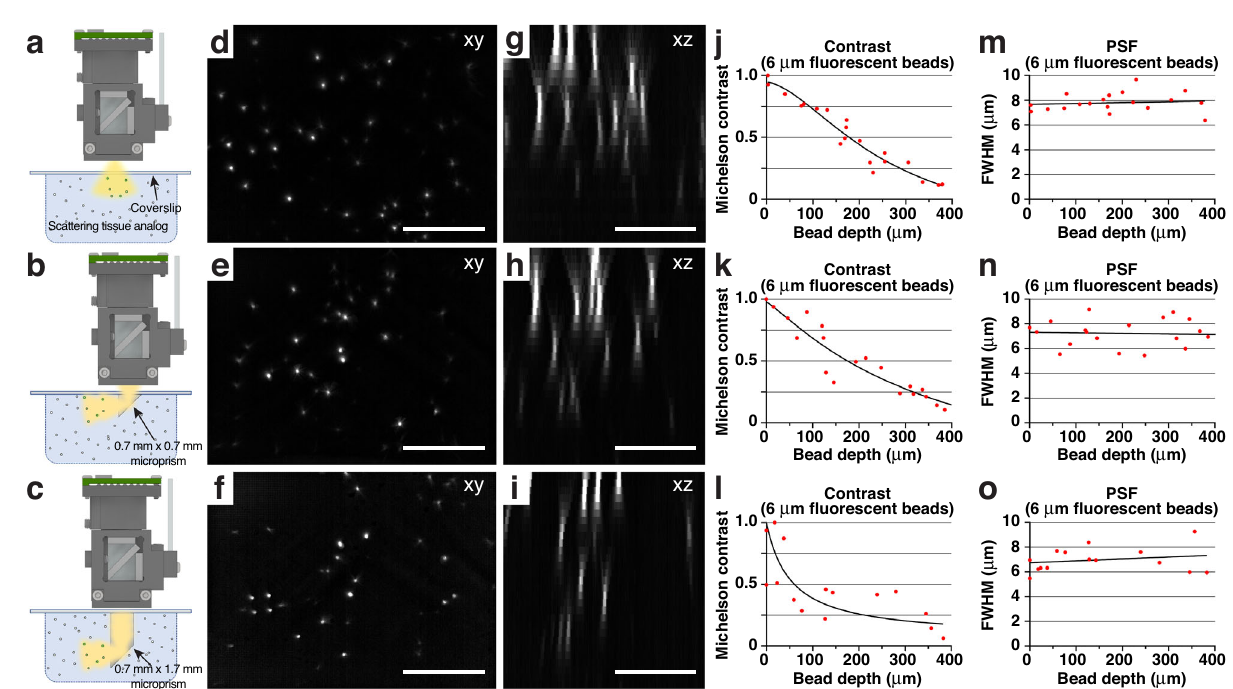
Fig. 3 | Wearable microscopes with custom-compound microlenses permit imaging through implanted microprisms. a – c Schematics showing the experi- mental approach for characterizing and comparing three imaging conditions in scattering tissue phantoms ( Methods ): Top , imaging through a coverslip; center , imaging through a coverslip with an attached 0.7mm×0.7mm×0.7mm micro- prism (W×D×H) with a re fl ective aluminum coating on the hypotenuse; bottom , imaging through a coverslip with an attached 0.7mm×0.7mm×1.7mm micro- prism with a re fl ective aluminum coating on the hypotenuse. d – f example images